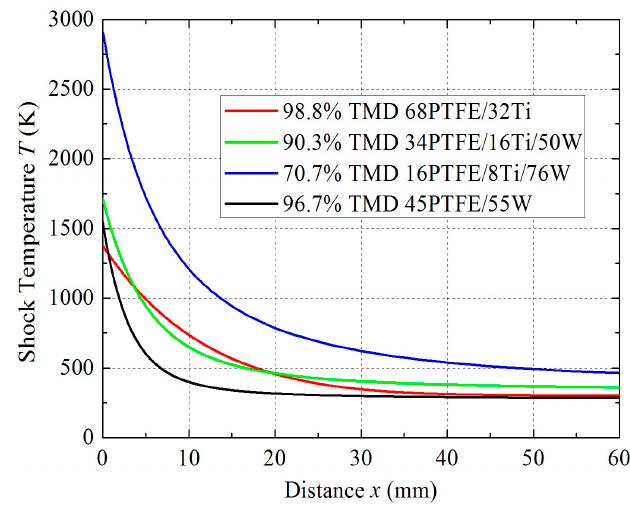
Figure 13. Temperature–distance curves for shock wave propagation.